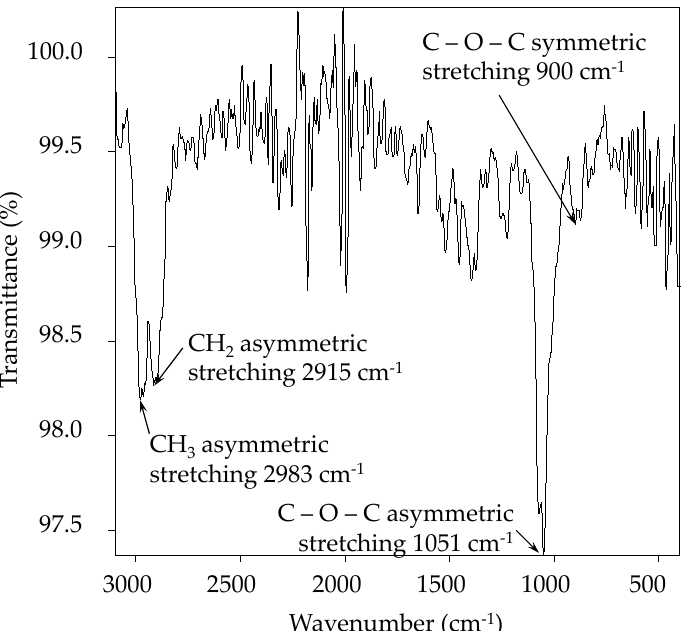
Figure 9. FTIR of a particle collected from the tarakihi fish digestive tract identified as polyethylene glycol.